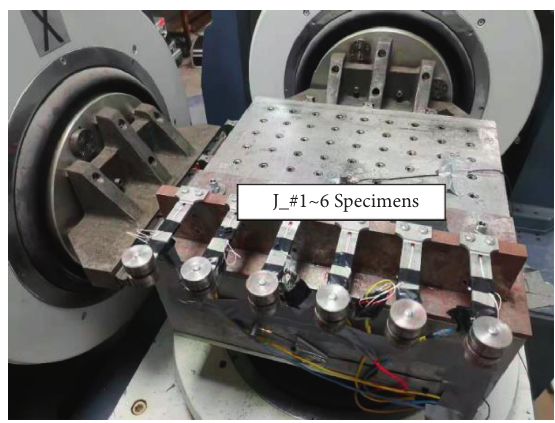
Figure 17: Sample number of the vibration endurance accelerated test. Table 5: Comparison of the accelerated fatigue life between the bench test and simulation